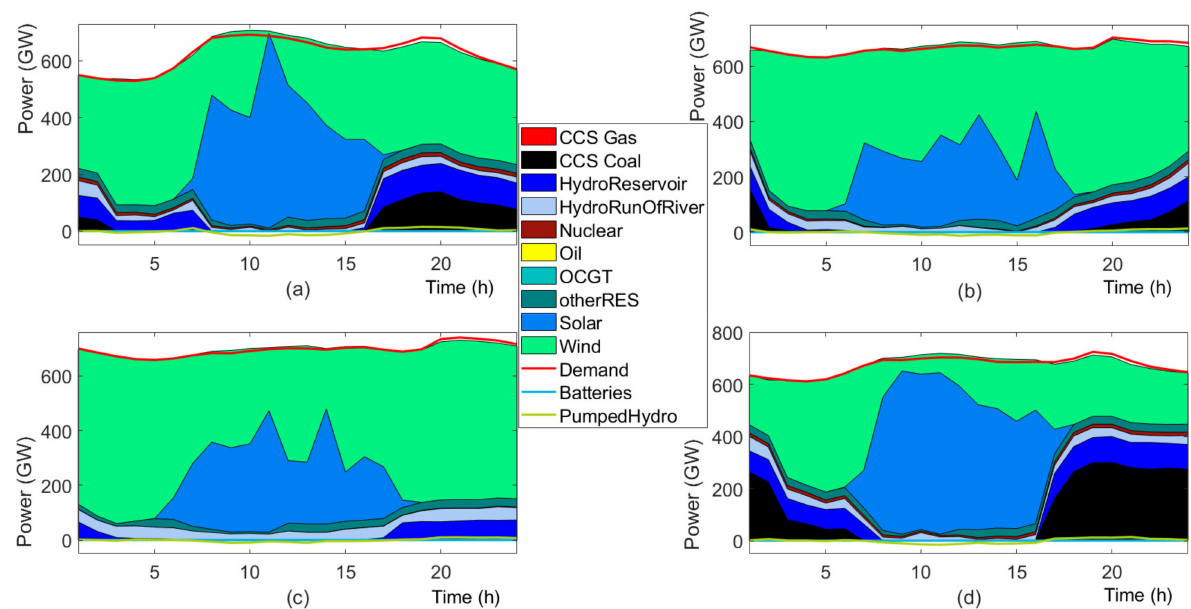
Figure 13. Generation mix in the year 2050 (specifically, scenario-tree node 8), without the availability of storage, in four typical days. Figure ( a ) reports a typical day within the period January–March, ( b ) a typical day within April–June, ( c ) a typical day within July–September, and ( d ) a typical day within October–December.